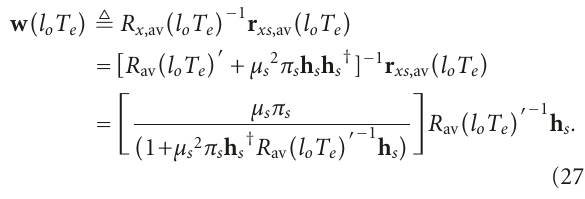
at Figure 2 where y vL (( l/q + n ) T ) (cid:2) (cid:5) w ( lT e ) † x v (( l/q + n ) T ), which is a complex quantity, replaces y v WL (( l/q + n ) T ) ap- pearing in Figure 1. For l = l o and as long as b Tv (( l/q + n ) T ) (cid:6) remains uncorrelated with s v ( nT ), (cid:5) w ( lT e ) becomes an esti- mate of the well-known linear SMF, w ( l o T e ), defined